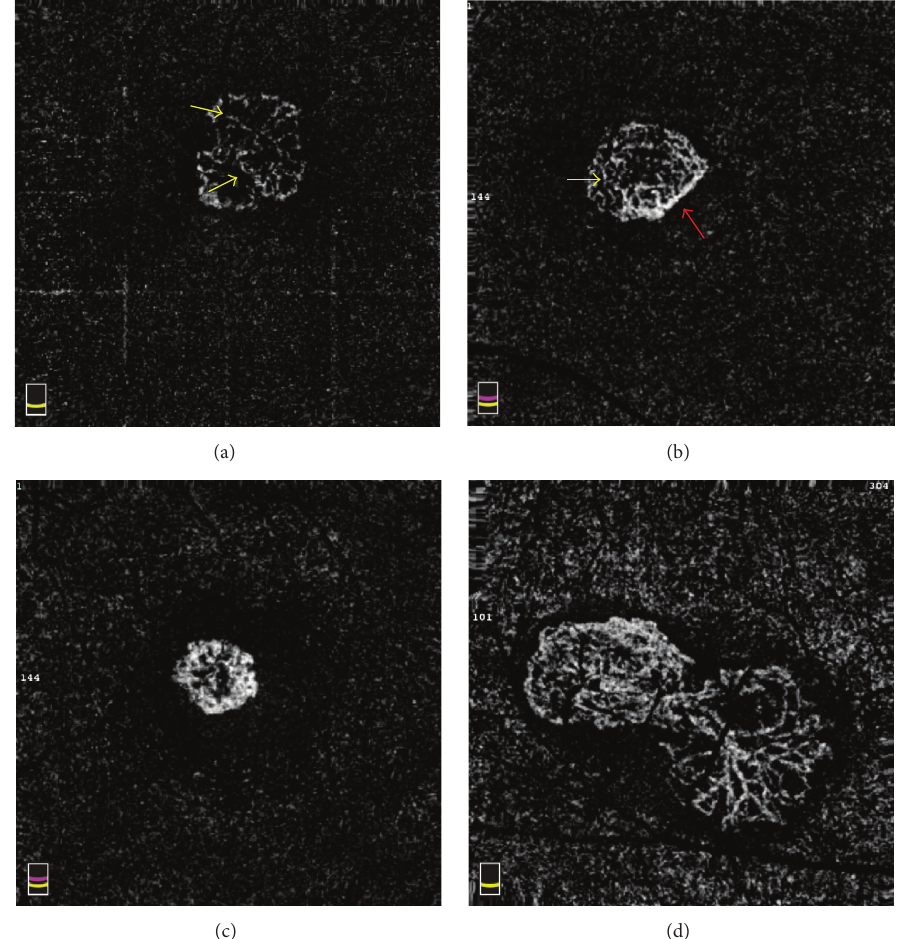
Figure 1: CNV structure of outer retinal layer on OCTA. (a) Irregular circumscribed CNV lesion with abnormal “tree-in-bud” blood flow inside (yellow arrows). (b) A round-like closed CNV with continuous linear peripheral flow (red arrow). (c) An irregular CNV as “medusa- shaped.” (d) The CNV had obvious dendritic branch vessels net from the